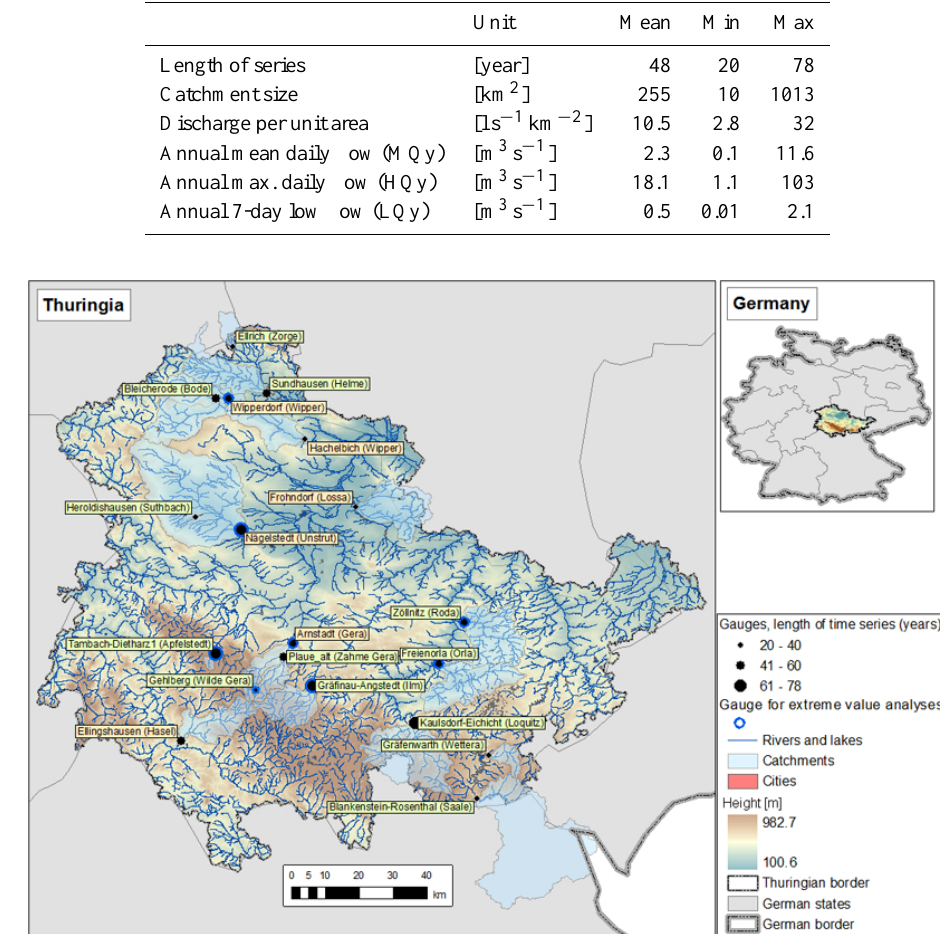
Table 1. Characteristics of the 19 analyzed time series, corresponding catchments and mean flow values.